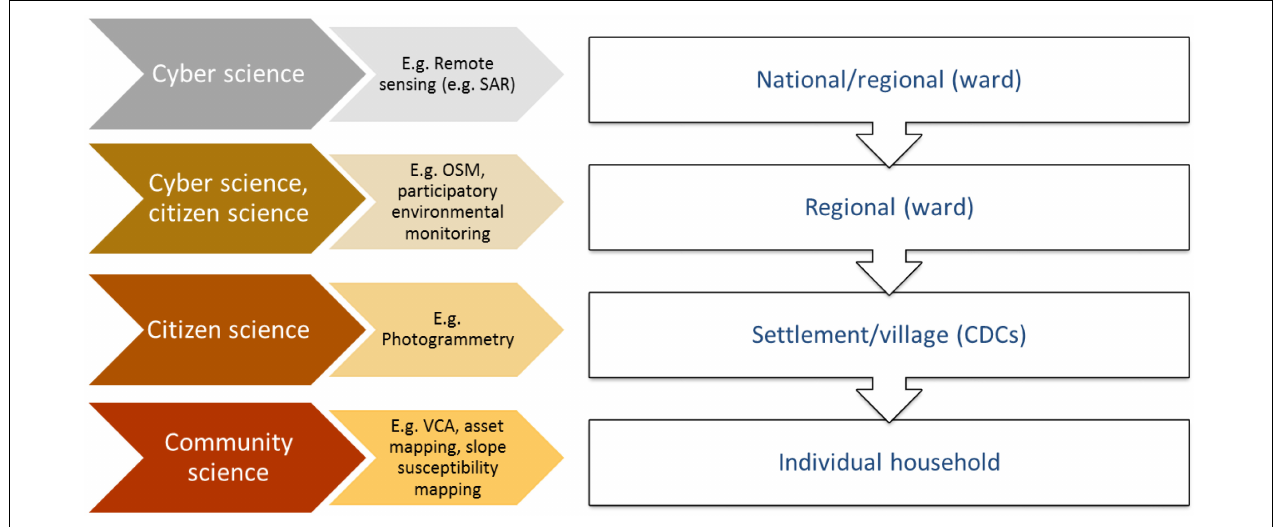
FIGURE 7 | Stakeholder levels for different types of participatory